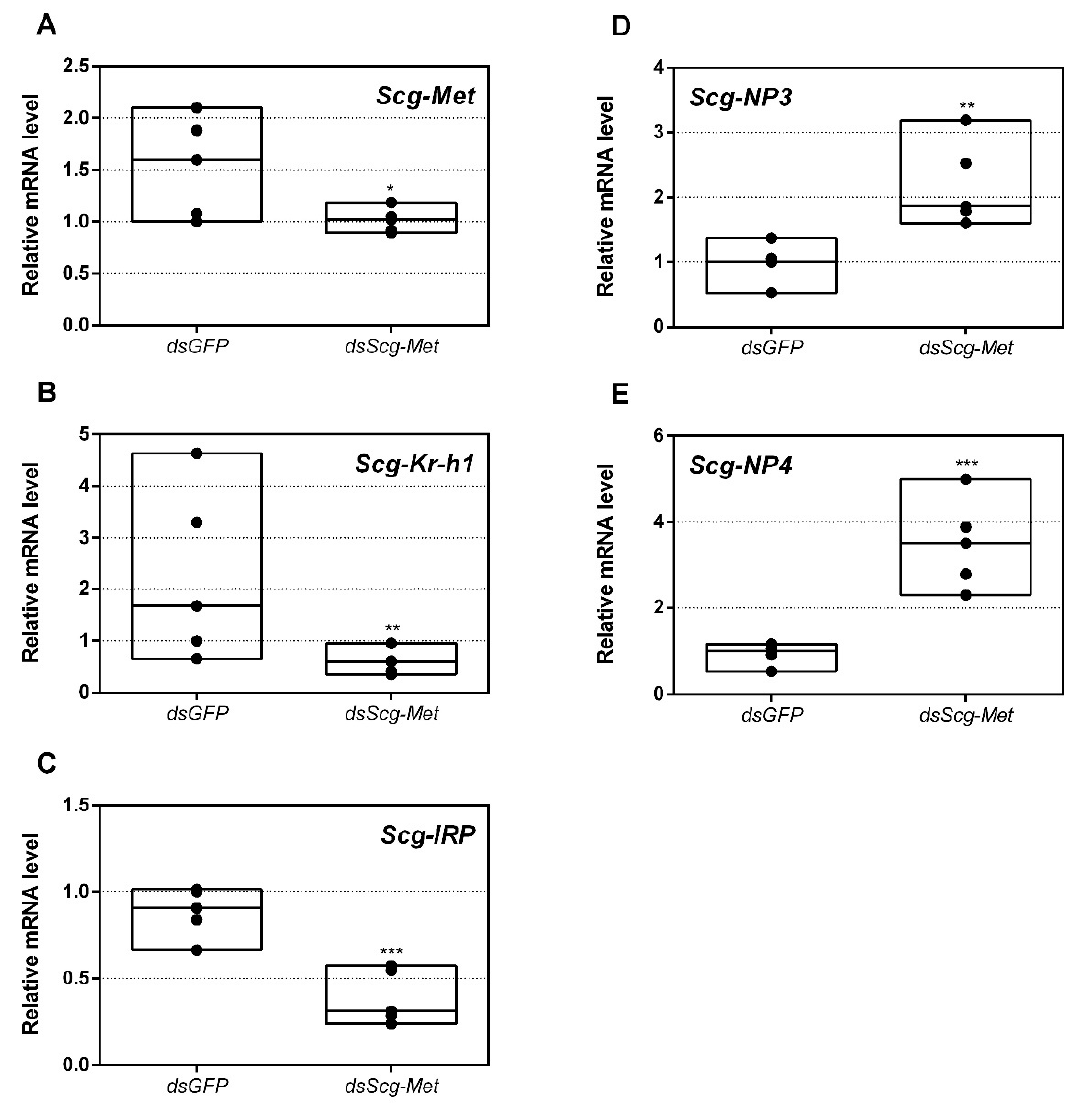
Figure 1. Relative mRNA levels measured in fat body tissue of dsGFP and dsScg-Met injected adult male desert locusts 34 days after the adult molt. ( A ) Transcript levels of Scg-Met were significantly reduced in the fat body demonstrating that the RNAi mediated knockdown was successful. Transcript levels of ( B ) Scg-Krh1 and ( C ) Scg -IRP were significantly reduced, while transcript levels of ( D ) Scg -NP3 and ( E ) Scg-NP4 were significantly increased in the fat body upon dsScg-Met treatment. Transcript levels in the fat body were normalized against two reference genes, Scg-Act and Scg-Ef1a . For every condition five biological replicates, each consisting of the pooled fat body samples from four individual locusts, were analyzed by q-RT- PCR. Data points are represented in a column graph as a floating bar (min to max value) with a line indicating the median. Significant differences (Student’s T-test) are indicated with asterisks (* p < 0.05; ** p < 0.01; *** p < 0.001). The following statistical p-values were obtained: Scg-Met ( p = 0.048), Scg-Krh1 ( p = 0.0021), Scg-IRP ( p = 0.0008), Scg-NP3 ( p = 0.0059), Scg-NP4 ( p = 0.0007). (Abbreviations: ds = double stranded, Scg = Schistocerca gregaria , GFP = Green Fluorescent Protein, Met = Methoprene-tolerant, Kr-h1 = Krüppel-homolog 1, IRP = insulin-related peptide, NP = neuroparsin, Act = actin, Ef1a = elongation factor